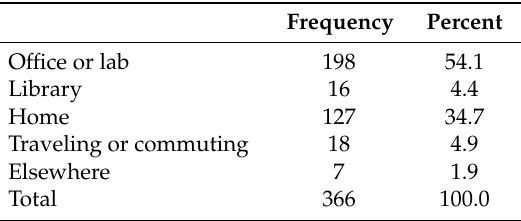
Table 21. Location of article reading.